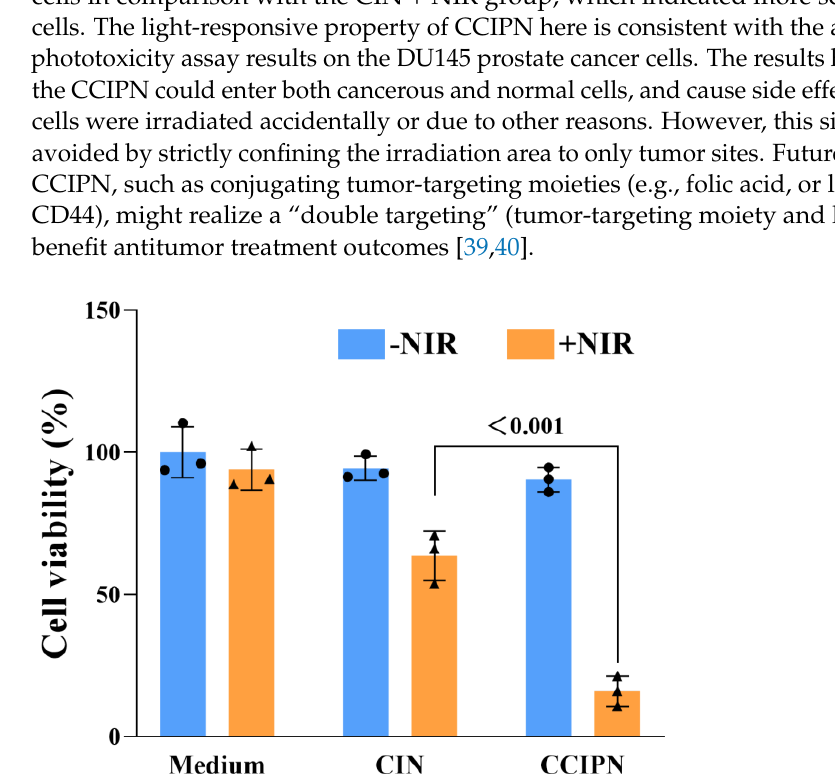
Figure 12. Investigation of the phototoxicity of CCIPN. Viability of HUVECs treated with culture medium, CCIPN at 0.075 µg mL −1 or CIN at 0.075 µg mL -1 under irradiation or no irradiation. Values are expressed as mean ± SD (n = 3). Each dot represents an independent experiment. The p value vs. indicated group is presented.